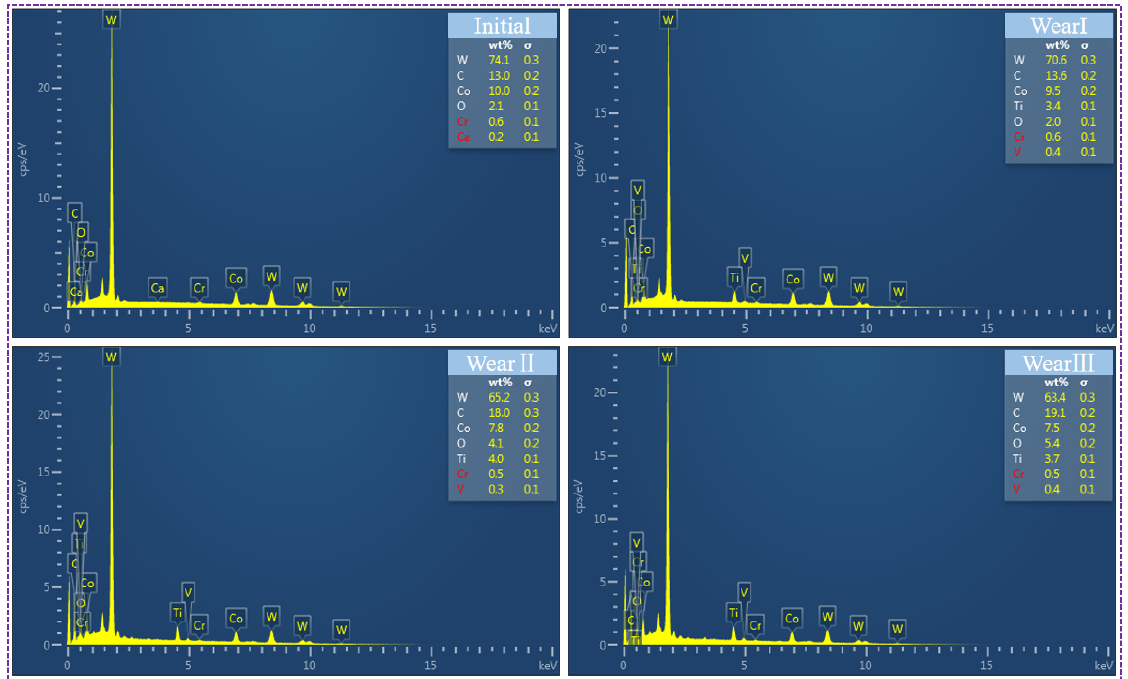
Figure 15. EDS analysis of micro-milling cutter with different wear states.